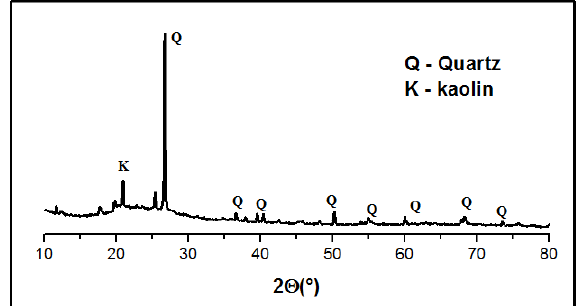
Figure 1: XRD of